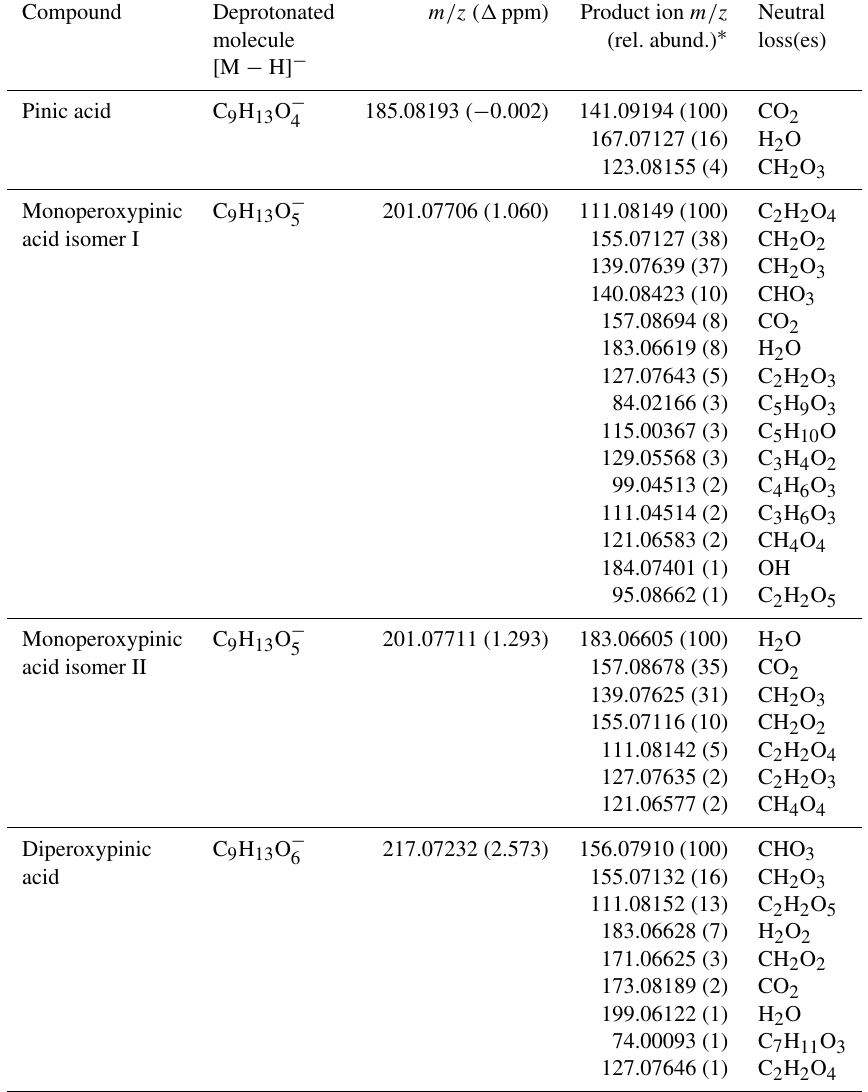
Table 1. MS/MS fragmentations of [M − H] − ions from pinic acid and its peroxyacid analogues. Compound Deprotonated m/z ( (cid:49) ppm) Product ion m/z Neutral molecule Pinic